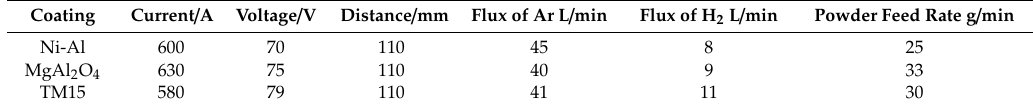
Table 1. Atmospheric plasma spraying